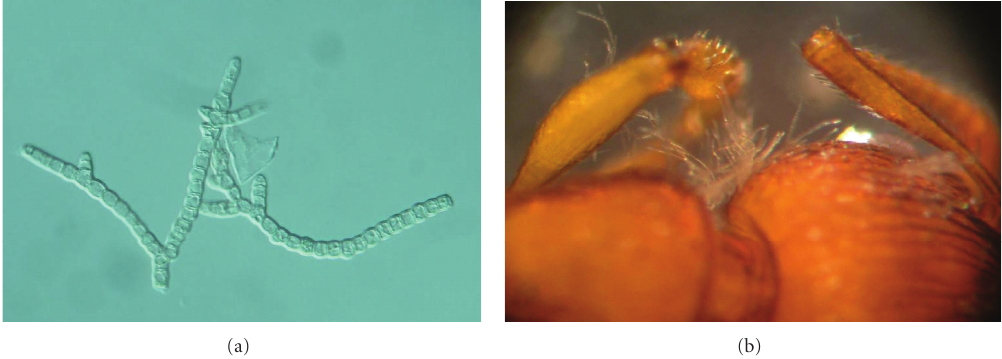
Figure 3: Hormiscium myrmecophilum . (a) hyphae on Myrmica sp.; (b) worker Myrmica sabuleti with hyphae on the head and lateral